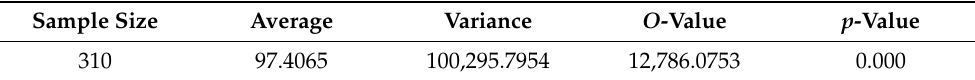
Table 4. Overdispersion O